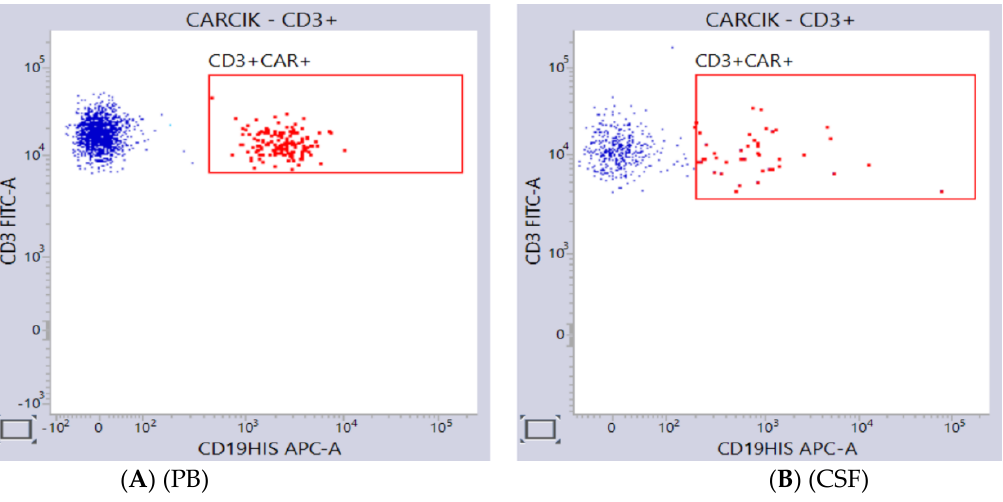
Figure 3. Detection of CARCIK-CD19 cells in the peripheral blood (Panel A , PB) and cerebral spinal fluid (Panel B, CSF) in an adult ALL patient. At day 28 from infusion, CARCIK-CD19 cells were simultaneously in PB (11/mcl) and CSF (1/mcl).